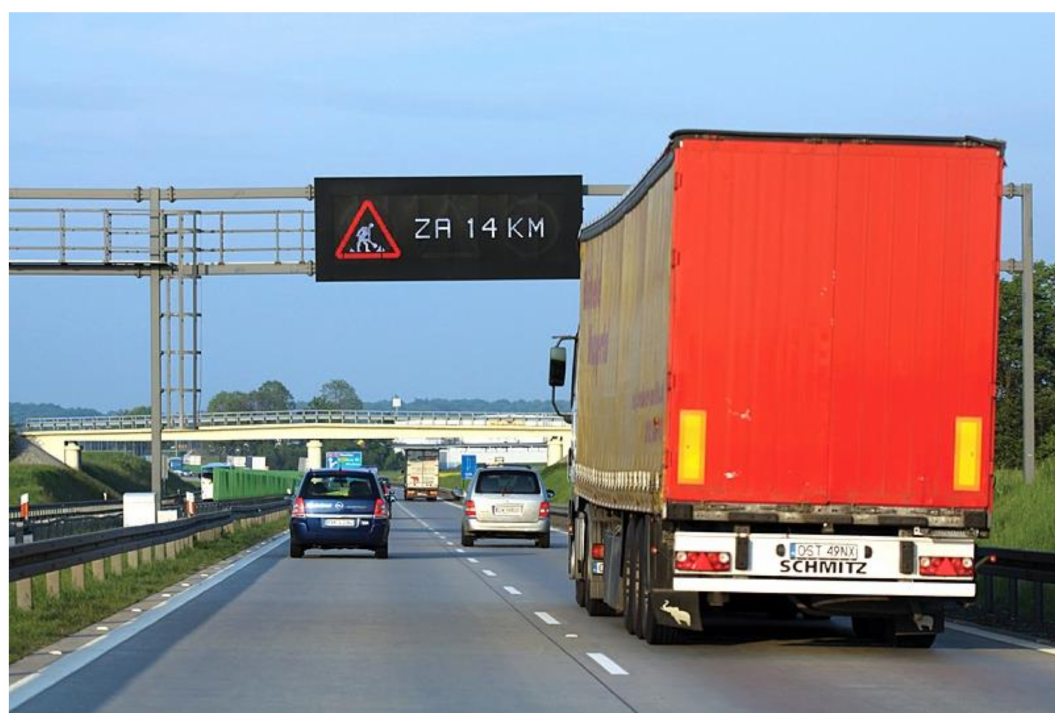
Figure 5. A variable message